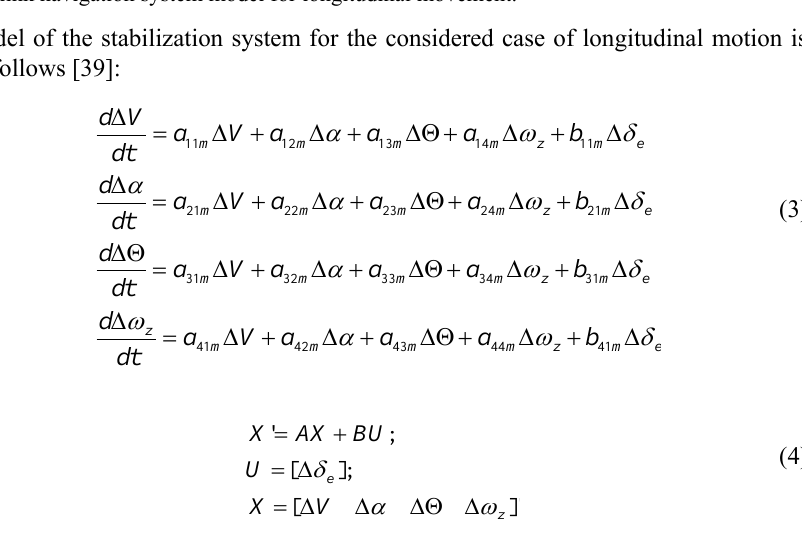
Fig. 1. Simulink navigation system model for longitudinal